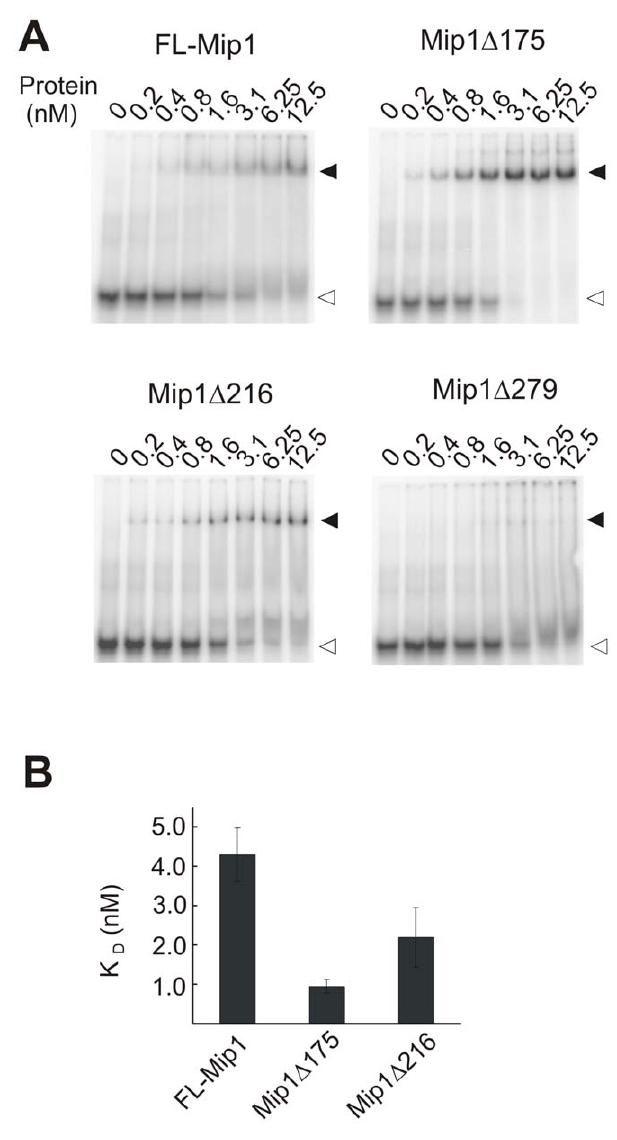
Figure 5. DNA binding affinity of Mip1 and C-terminal deletion mutants. DNA binding was measured with an electrophoretic mobility shift assay using an oligomeric substrate of 45 nt template strand and a radiolabeled 25 nt primer. 0.2–12.5 nM polymerase was incubated for 2 min at 0 u C with 1 nM substrate. A. Reaction products were resolved on a native Tris-glycine 8% polyacrylamide gel. Positions of the free and bound substrate are indicated accordingly with empty and filled triangles. B. The dissociation constant K D (nM) was calculated from the logarithmic binding curve as the concentration of the polymerase when 50% of the substrate was bound. Data from three independent experiments was used to establish the average K D and standard deviation